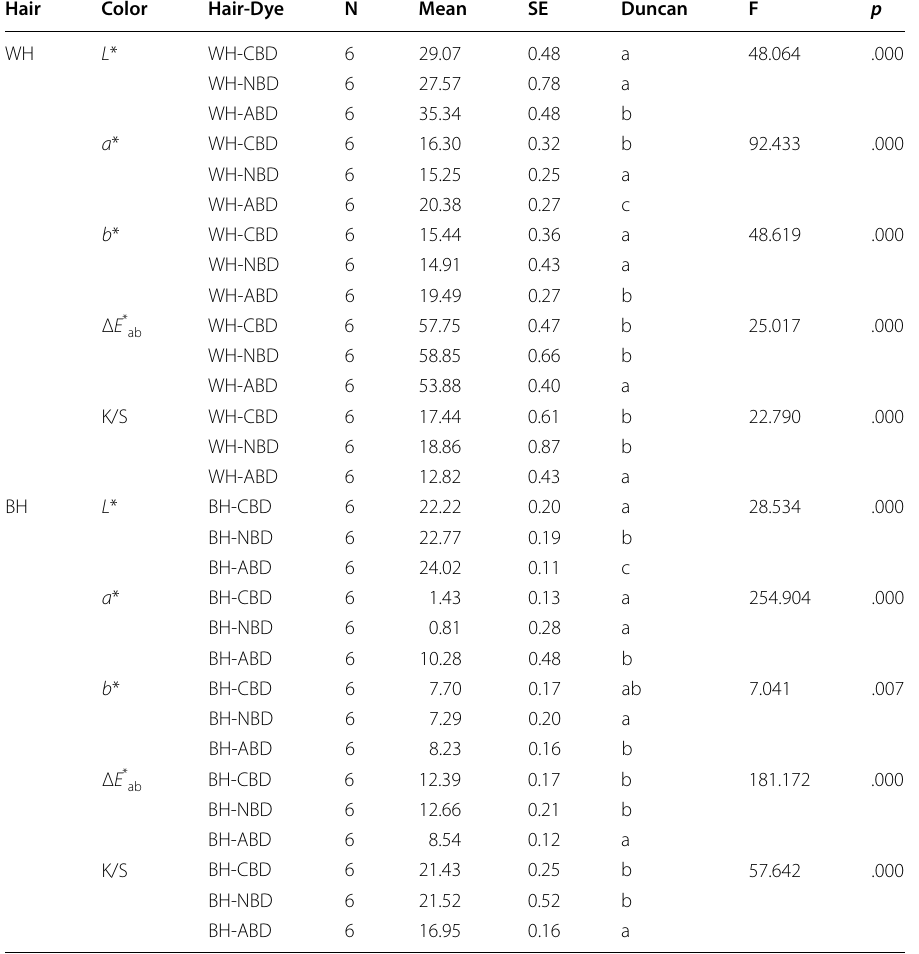
Table 7 Comparison of the color difference and the K/S values of white hair (WH) and bleached hair (BH) by dye type (α =